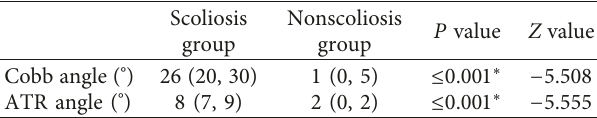
Table 5: Descriptive statistics of Cobb angle and ATR angle in two groups.